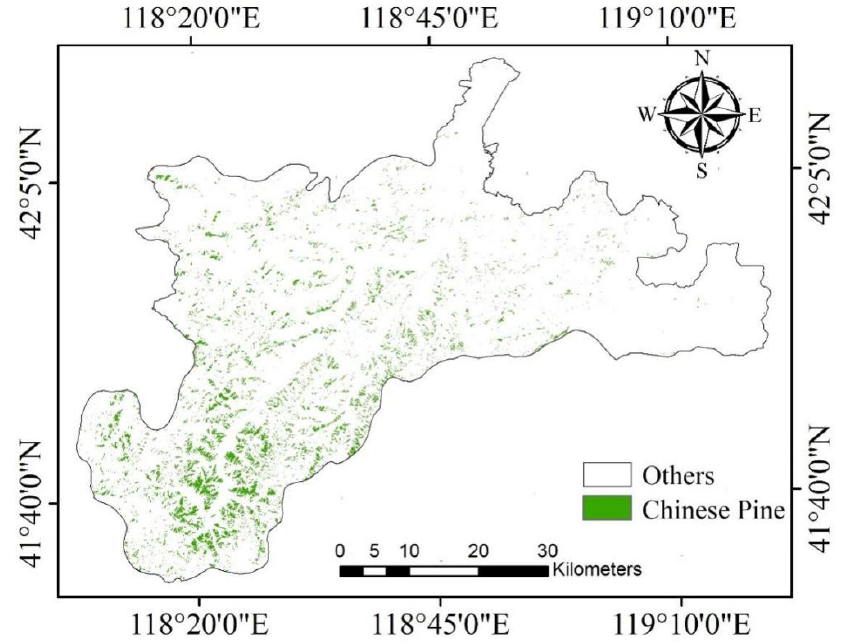
Figure 3. One of the extraction results of Chinese pine.